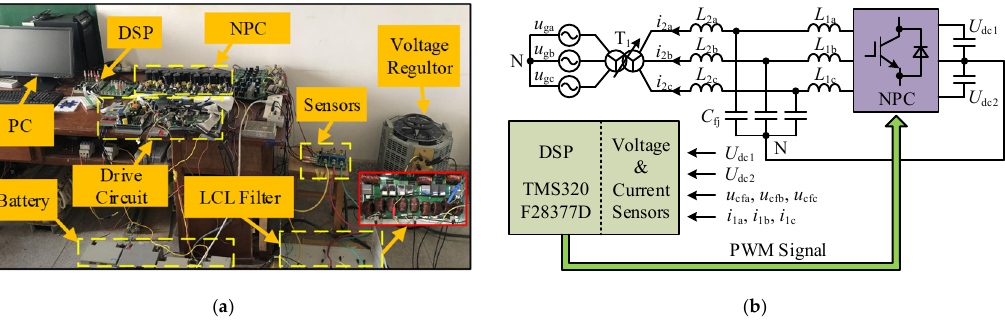
Figure 13. Three-phase LCL grid-connected inverter experimental setup: ( a ) Picture of the real products; ( b ) schematic diagram .